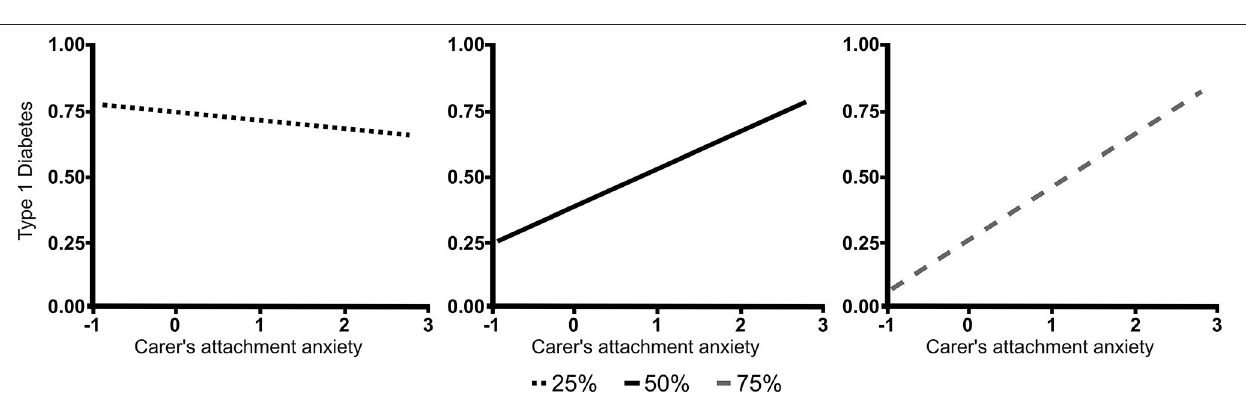
FIGURE 3 | The relationship between carers’ attachment anxiety and children’s T1D for different levels of mothers’ education. The figure shows significant slopes for the three levels of mothers’ education. In the mothers with higher than secondary education, higher level of carers’ attachment-related anxiety was positively associated to T1D in children. This was not the case for mothers with secondary or lower education. Type 1 diabetes—type 1 diabetes in children; Carers’ attachment anxiety—carers’ ECR-RS general anxiety; 25, 50, and 75% − 7 levels of education presented as median and quartiles (25%—finished high school or less, 50%—unfinished or finished college, unfinished university,